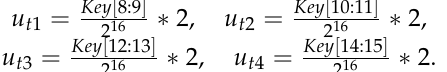
Figure 5. The structure of the original four stage CML based on the tent map. In this structure, the key length of the input key, Key, is 128-bit or 16-byte as the